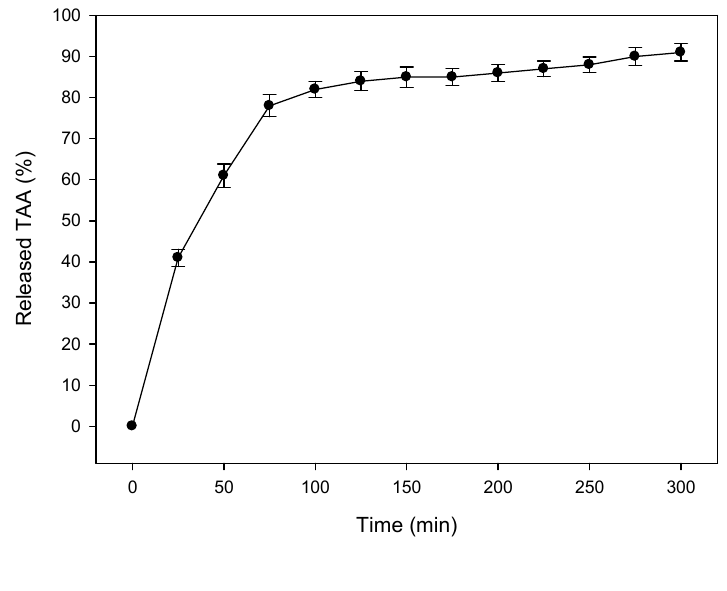
Figure 5. Drug release of crosslinked PAA loaded with triamcinolone acetonide. TAA, triamcinolone